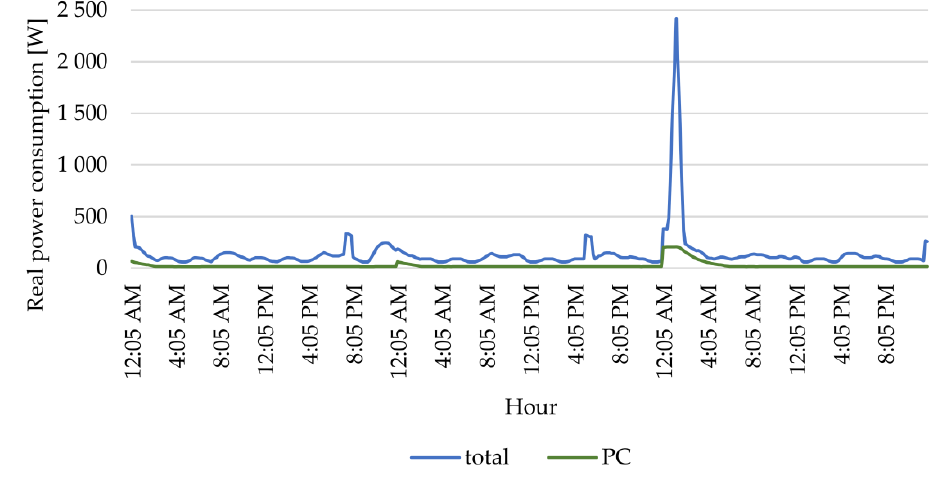
Figure 10. Total electricity consumption generated by a PC over four days.